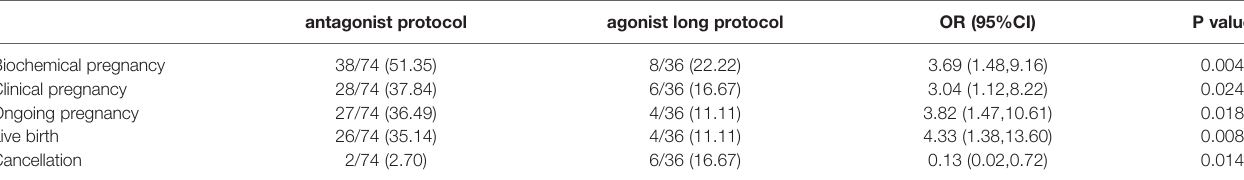
TABLE 3 | Clinical outcomes in antagonist vs. agonist long protocol